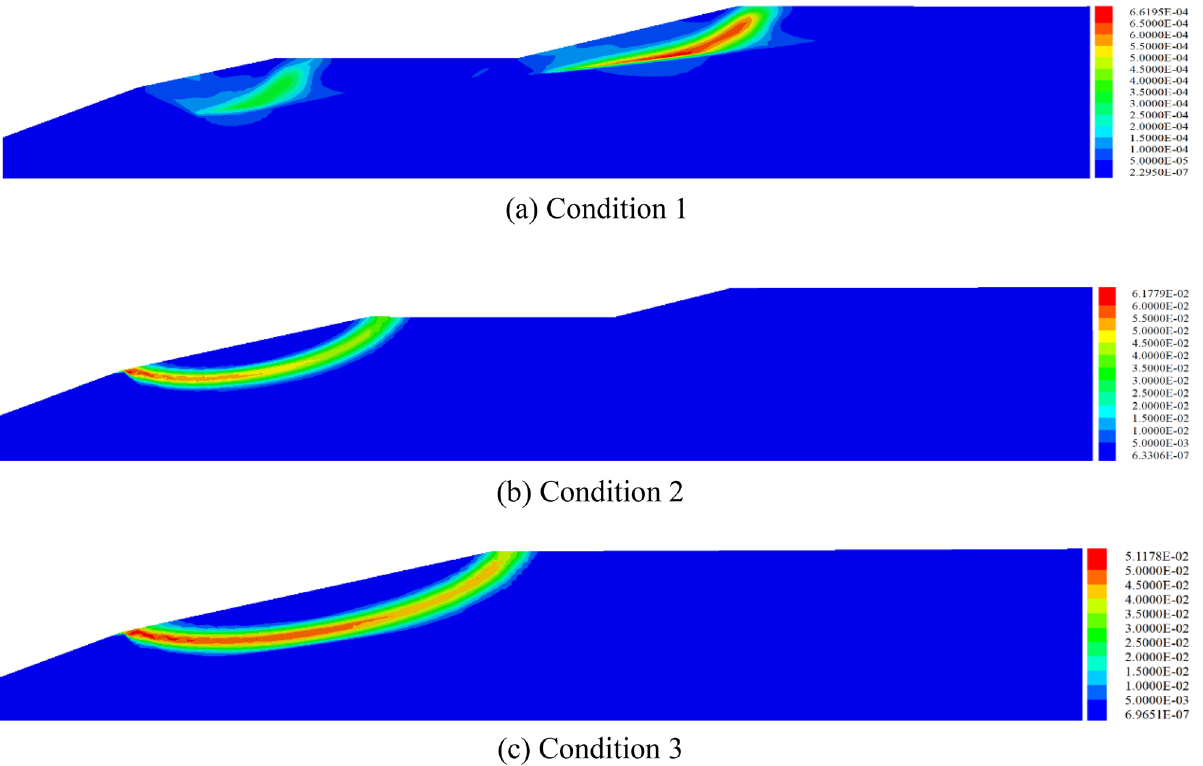
Figure 10. Distribution of the maximum shear stress in the reservoir